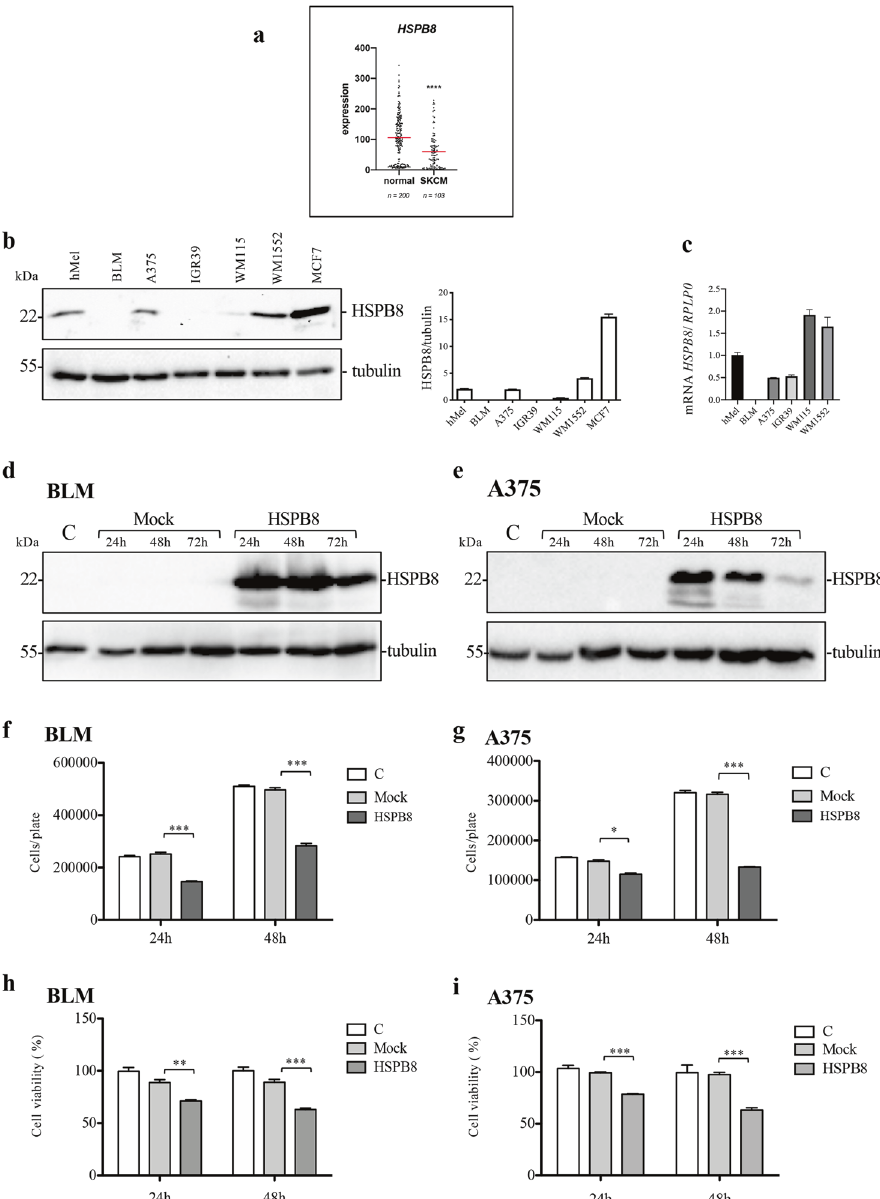
Fig. 1 Expression of HSPB8 in melanoma cell lines. a Analysis of HSPB8 gene expression in skin cutaneous melanoma (SKCM) vs normal tissue (skin) as reported in OncoDB database. Scatter plot represents the mean of HSPB8 expression value (red line) obtained from RNA-Seq data normalized using Transcripts Per Million (TPM). Student ’ s t -test (**** p < 0.0001) b HSPB8 expression levels in different melanoma cell lines compared with human melanocytes and MCF-7 breast cancer cells. Tubulin was used as loading control. Three independent biological samples for each condition were analyzed ( N = 3), bar graph represents the mean optical density ± SD. c HSPB8 mRNA expression in different melanoma cell lines analyzed by RT-qPCR. Data have been normalized to the amount of RPLP0 mRNA. Bar graph represents the mean of four independent biological samples ( N = 4) ±SD. d , e HSPB8 WB analysis of BLM ( d ) and A375 ( e ) cells overexpressing HSPB8. f , g Cell count assay was performed in BLM ( f ) and A375 ( g ) cells overexpressing HSPB8. Four independent biological samples for each condition were analyzed ( N = 4), bar graph represents the mean relative cell count ± SD. Statistical analysis was performed using Student ’ s t -test (* p < 0.05 vs. mock 24 h; *** p < 0.001 vs. mock 24 h and 48 h). h , i Cell viability assay was performed in BLM ( h ) and A375 ( i ) cells overexpressing HSPB8. Six independent biological samples for each condition were analyzed ( N = 6), bar graph represents the mean relative cell viability ± SD. Statistical analysis was performed using Student ’ s t -test (** p < 0.01 vs. mock 24 h; *** p < 0.001 vs. mock 24 h and 48 h).